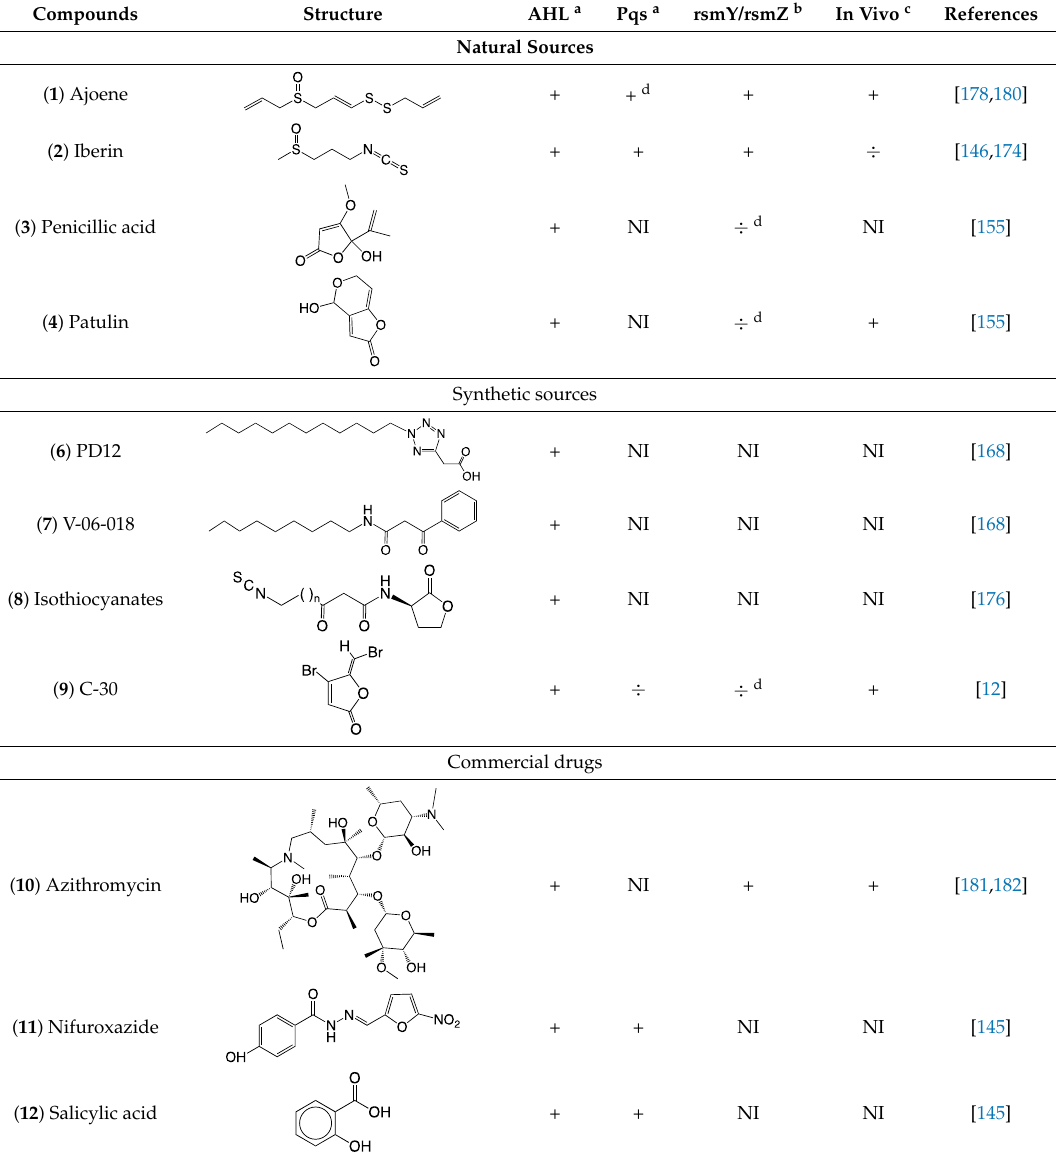
Table 1. Examples of inhibitors of the N -acyl- L -homoserine lactone (AHL) and ( Pseudomonas quinolone signal) PQS part of the quorum sensing system and/or the Gac/Rsm cascade by rsmY and rsmZ inhibition from natural or synthetic sources as well as commercial drugs against P. aeruginosa. Compounds